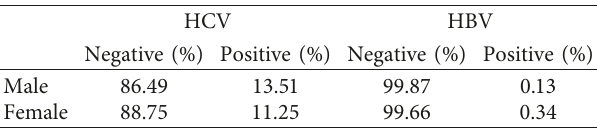
Table 1: Prevalence of HBV 1 and HCV 2 among males and females undergoing elective eye